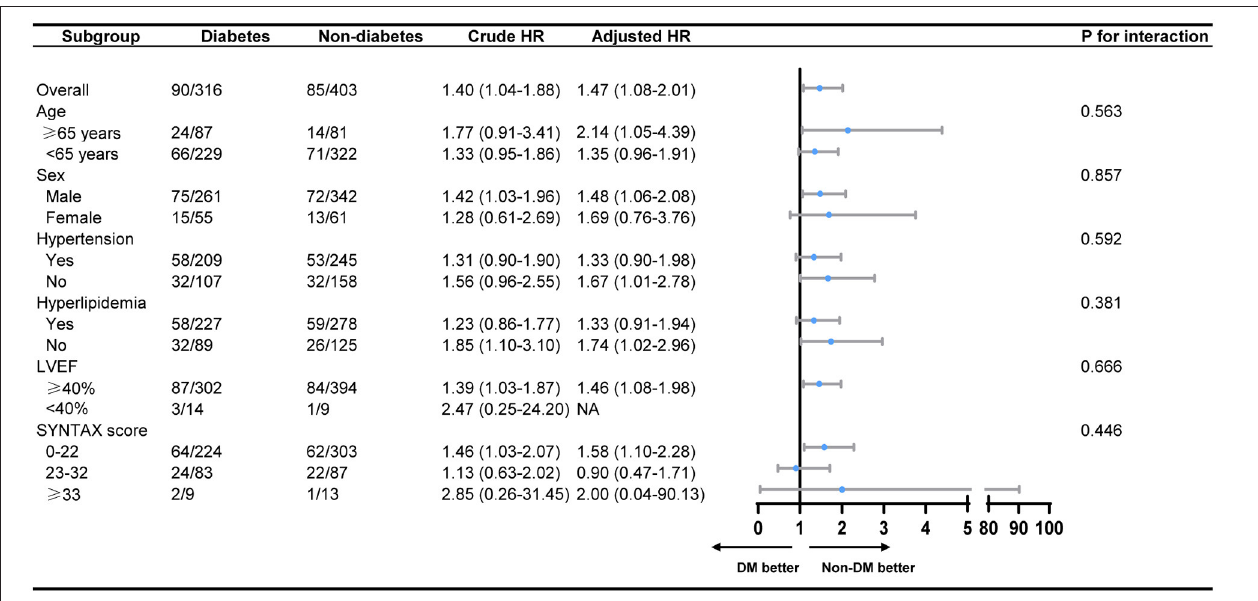
FIGURE 3 | Subgroup analysis on MACCE between the diabetes group and the non-diabetes group. MACCE, major adverse cardiac and cerebrovascular events; LVEF, left ventricular ejection fraction; LAD, left ascending coronary artery; NA, not